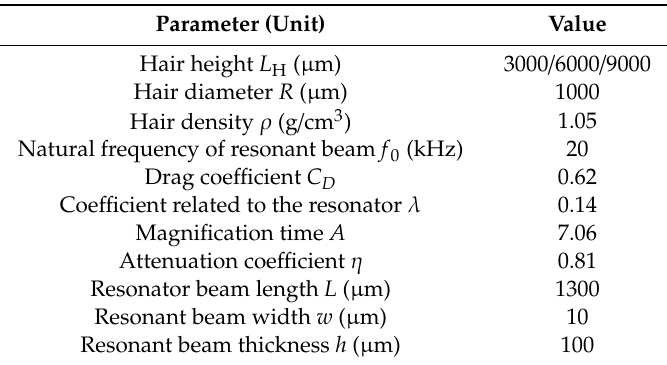
Table 1. Structure